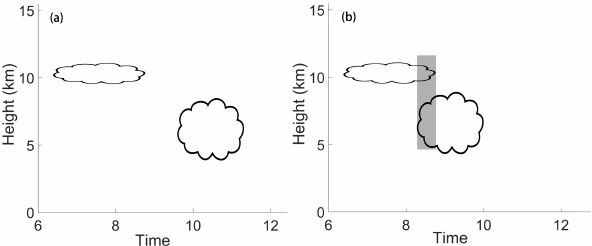
Figure 2. When multilayer clouds exist, the radar CTH is the mean CTH of all cloudy profiles but not upper-level cloud if (a) upper- level cloud and low-level cloud is situated separately or if (b) upper- level cloud covers part of the low-level cloud. The CTH of the grey “covered” part of low-level cloud is not